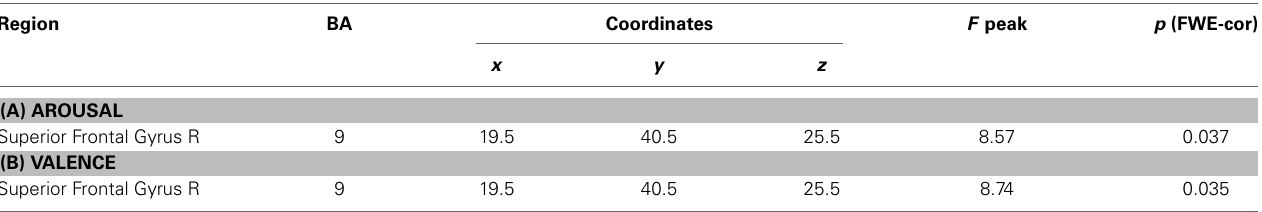
Table 6 | Regional brain Patterns of GM volume correlated with task performance in controls. Region BA Coordinates F peak p